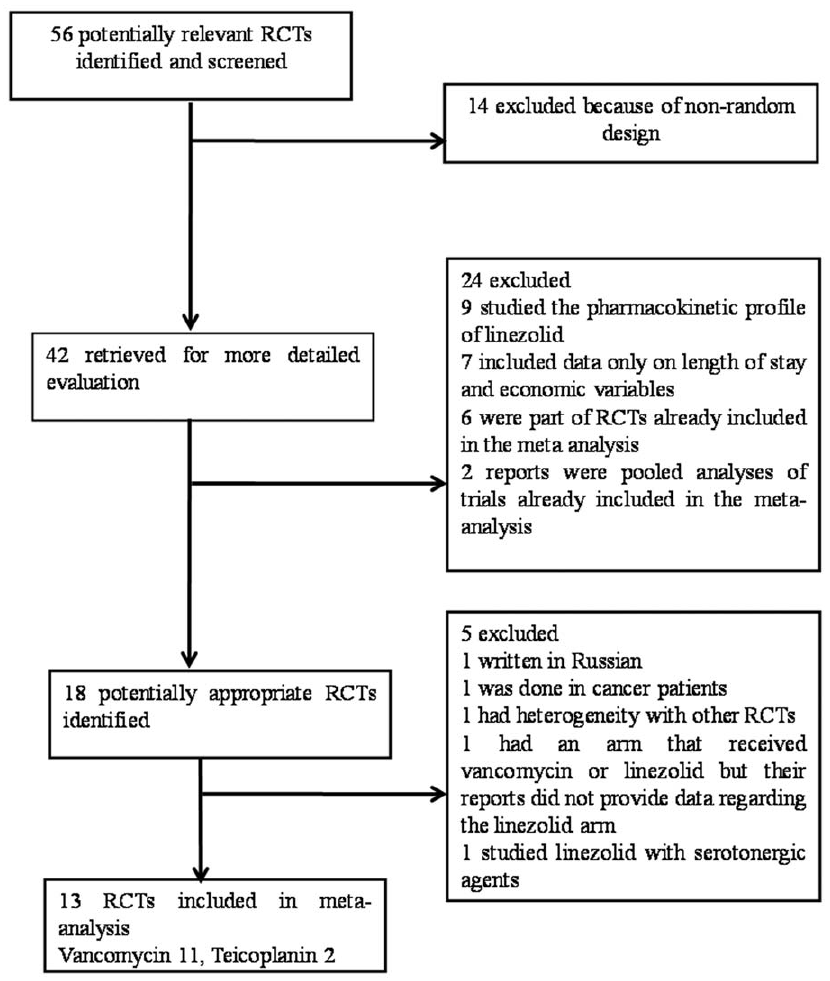
Figure 1. Flow diagram of the randomized controlled trials (RCTs) for meta-analysis.